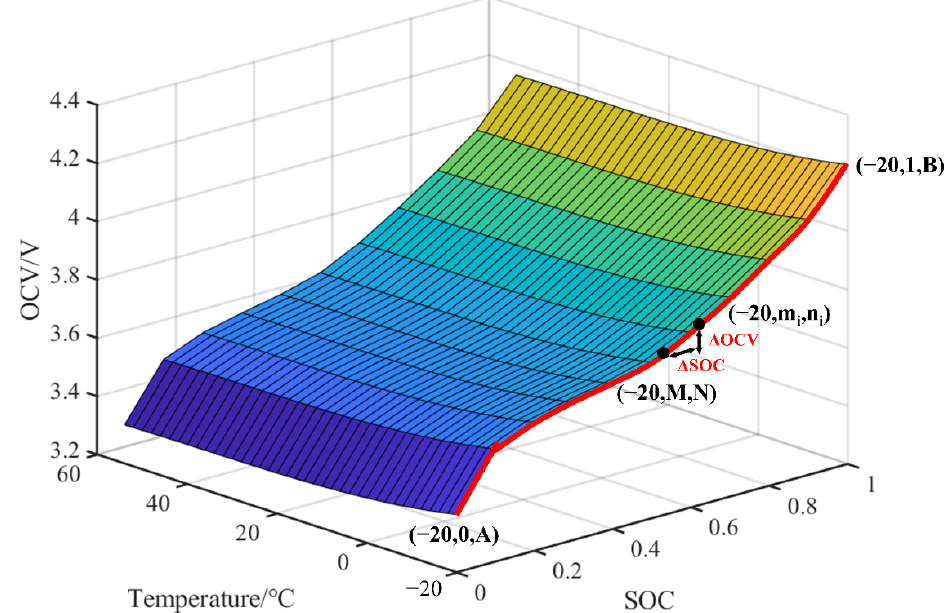
Figure 2. SOC–Temperature–OCV three-dimensional schematic of the NMC batteries.